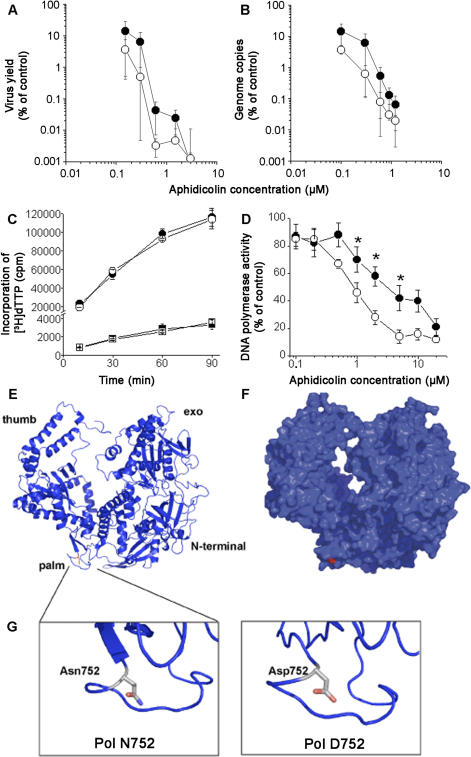
Differential Sensitivity of the Pol D/N752 Virus and Protein Variants to Aphidicolin and Structural Modeling of the Pol Region of Interest(A) Cells were infected with the Pol D752 revertant (•) or N752 mutant (○) virus, treated with aphidicolin, incubated 3 d, then lysed; final virus yield was titrated on new cells.(B) DNA was also extracted after the lysing step and qPCR performed to quantify normalized viral genome copies.(C) The DNA polymerase activity of Pol D752 and Pol N752 proteins, in the absence and in the presence of pORF18 (Pol accessory subunit), was analyzed by measuring the incorporation of [3H]dTTP into a poly(dA)-oligo(dT) template. (▪) Pol D752; (□) Pol N752; (•) Pol D752 + pORF18; (○) Pol N752 + pORF18.(D) The effect of aphidicolin on polymerase activity of Pol D752 (•) and of Pol N752 (○) was assayed by measuring the incorporation of [3H]dTTP into a poly(dA)-oligo(dT) template in the presence of pORF18. Graphs show the average of three experiments with standard deviations (error bars). Asterisk * indicates p < 0.05.(E) Ribbon diagram of EHV-1 Pol N752 is based on HSV-1 Pol crystal structure [23].(F) Space-filling diagram highlights the region between HSV-1 Pol secondary structure elements P3 and PB on the outside surface of the palm domain.(G) Prediction of structural changes caused by the residue variation in Pol N752 as opposed to Pol D752.